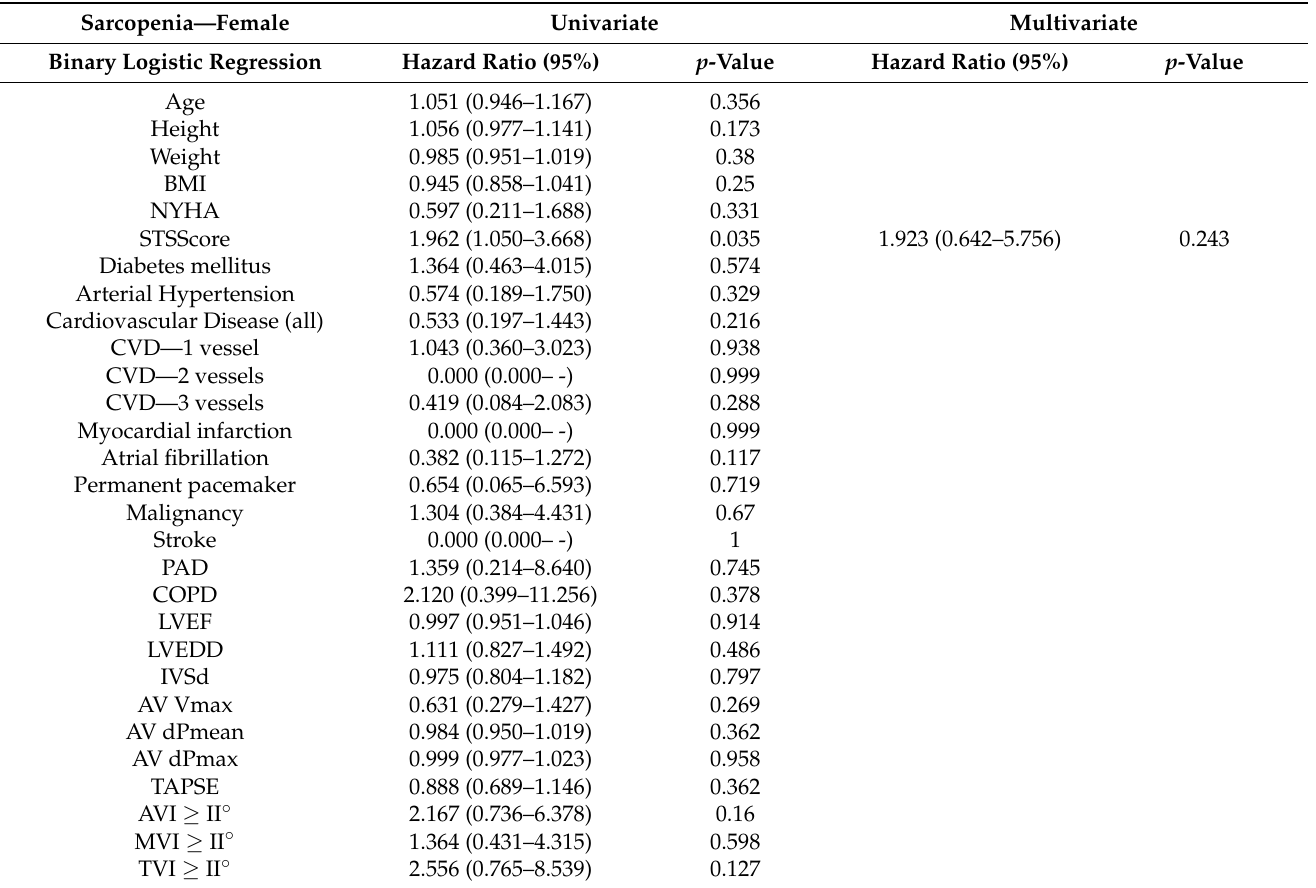
Table 5. Univariate and multivariate binary logistic regression analysis of female patients for the detection of predictors of